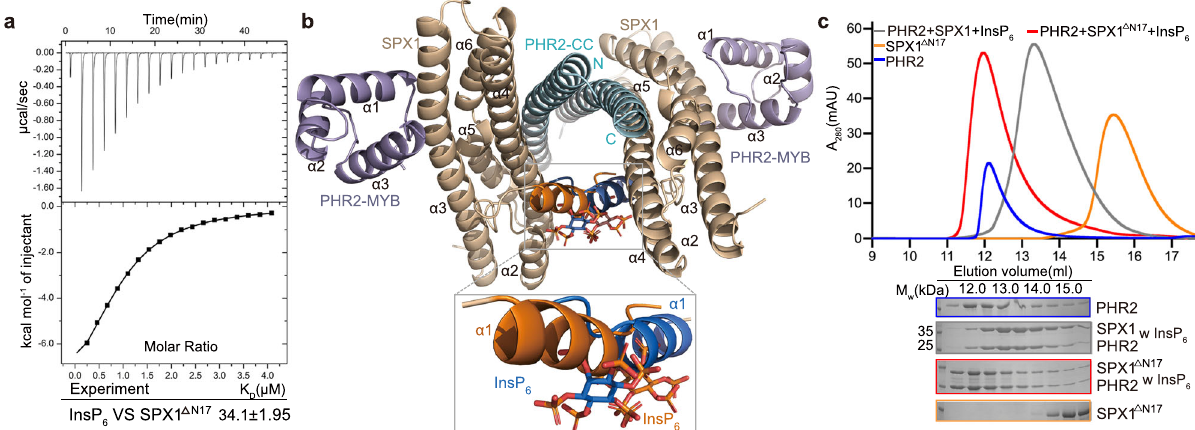
Fig. 4 SPX1 helix α 1 interferes the PHR2 dimer. a Binding af fi nity of InsP 6 with SPX1 1 – 259 ▵ N17 (N-terminal helix α 1 deletion of SPX1 1 – 259 ) was measured by ITC. b PHR2 dimer model constructed by superimposing PHR2 CC in InsP 6 -SPX1-PHR2 ternary complex structure with AtPHR1 CC dimer structure. The obvious clash occurred between the two helixes α 1 was shown in the close-up view. Two helixes α 1 of SPX1 were represented in orange and blue respectively. c SPX1 1 – 259 ▵ N17 impaired the SPX1 1 – 259 -PHR2 230 – 426 interaction. SPX1 helix α 1 is essential for PHR2 dimer dissociation. The assays were performed as described in (Fig.1a). Experiments were independently repeated three times with similar results. Uncropped gel images are available as source